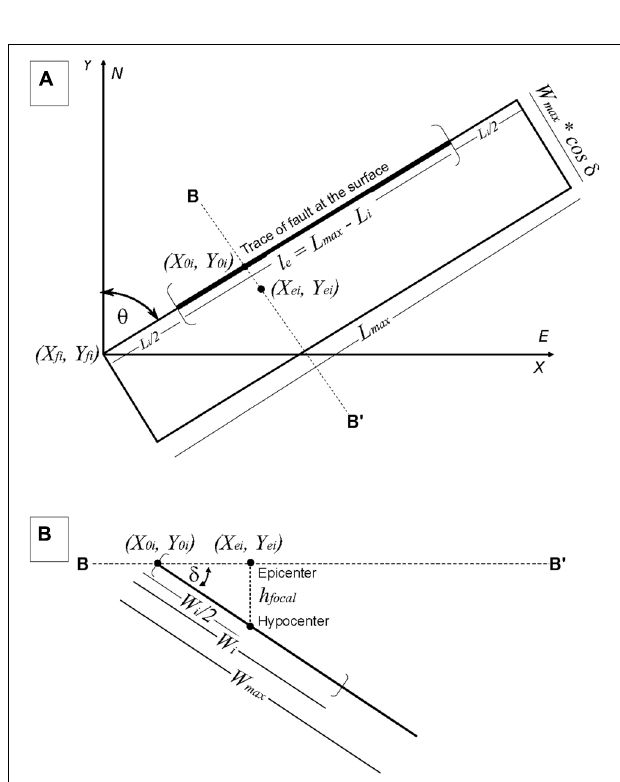
FIGURE 6 | Fault parameters. (A) Map view; (B) Cross section B - B (cid:48)